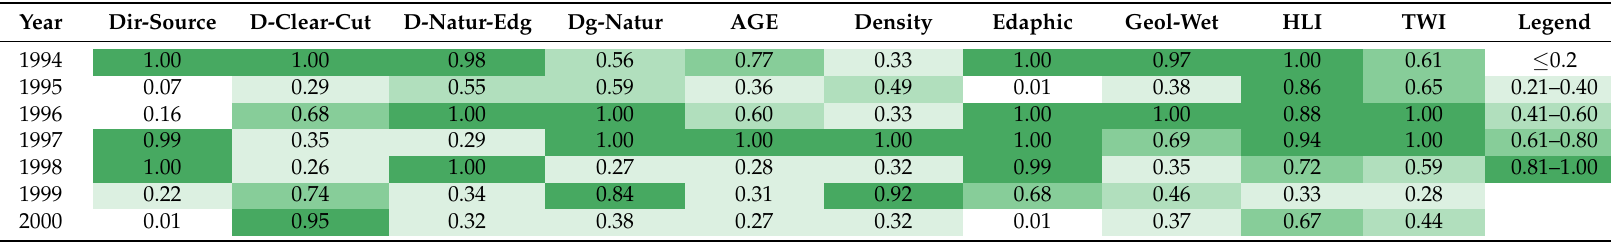
Table A3. Predictor importance weights based on multimodel inference when no pre-disturbance index is used as a predictor. The darkest/lightest green show the highest/lowest predictor importance weights.